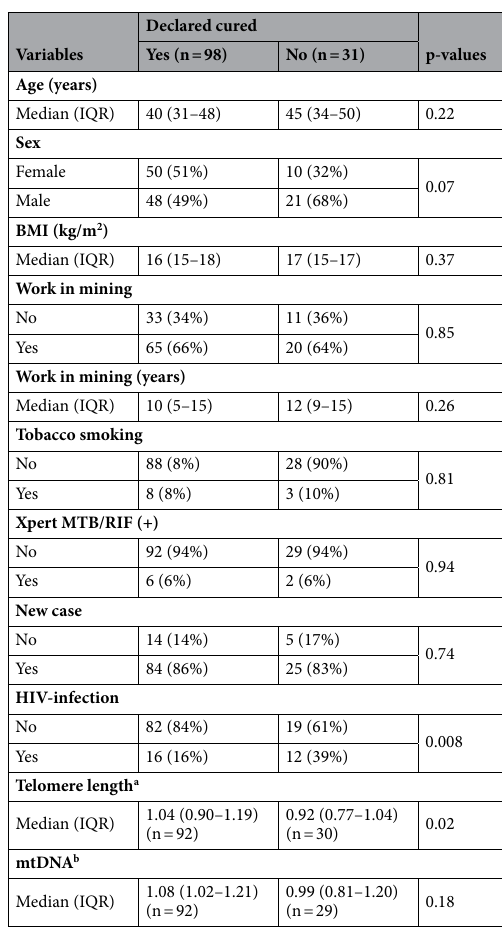
Table 2. Characteristics at inclusion of 129 PTB patients according to treatment outcome. Data are shown as n (%) otherwise as median and interquartile range (IQR). BMI body mass index, Xpert MTB/RIF automated